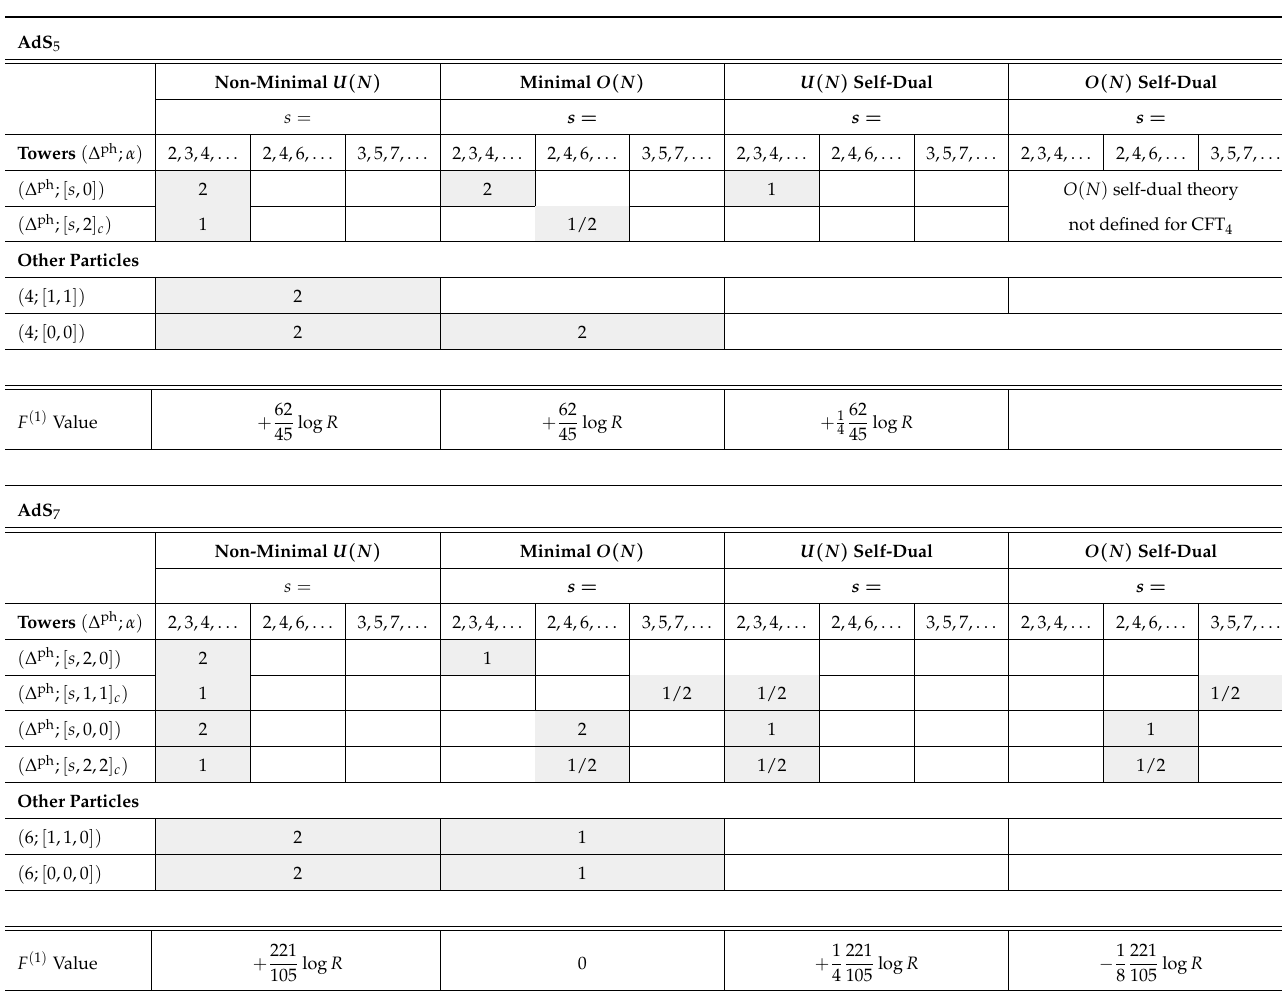
Table A8. Spectra of type C